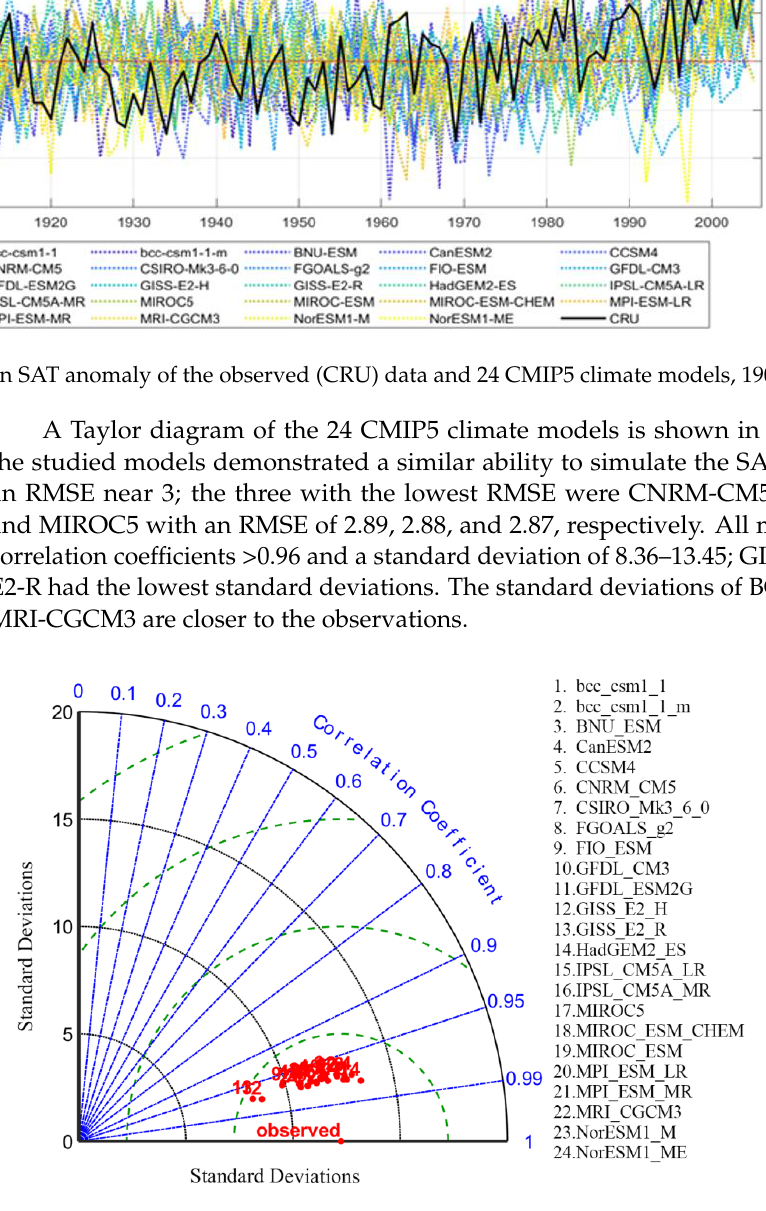
Figure 4. Taylor diagram comparing the observed data with the annual mean SAT as simulated